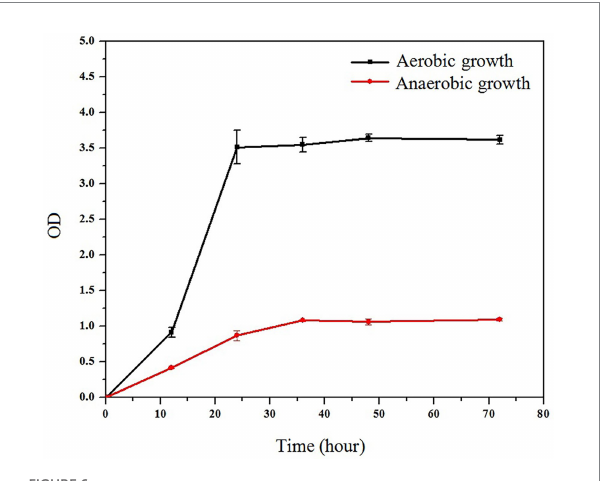
FIGURE 6 Growth curve of ZJW-6 under aerobic and anaerobic